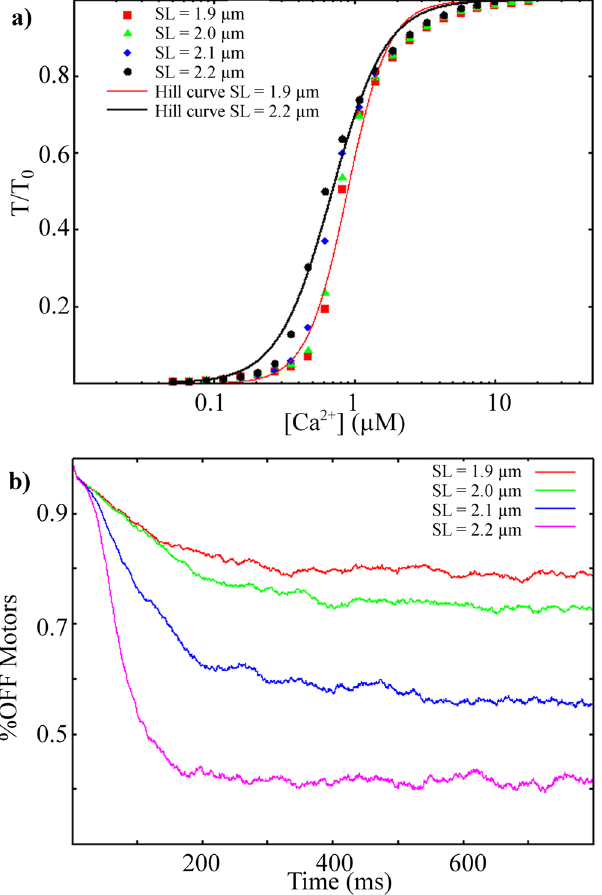
Figure 3. Simulations of force–pCa curves at different SLs. Upper: Maximum force at different [Ca 2 + ] values, without titin tension (at SL = 1.9 µ m, red dots) and with increasing titin tensions at higher SLs. Force–pCa curves are shifted to the left at higher SLs, as was also observed experimentally. Continuous lines represent the best fits with Hill’s curves, for SL = 1.9 μ m (red) and SL = 2.2 μ m (black). Bottom: Relative number of motors in the OFF state at steady [Ca 2 + ] = 0.6 µ M. The higher number of active motors at higher SLs, generating higher steady values of attached motors and, thus, higher active tension values, shifting the pCa–force curve to the